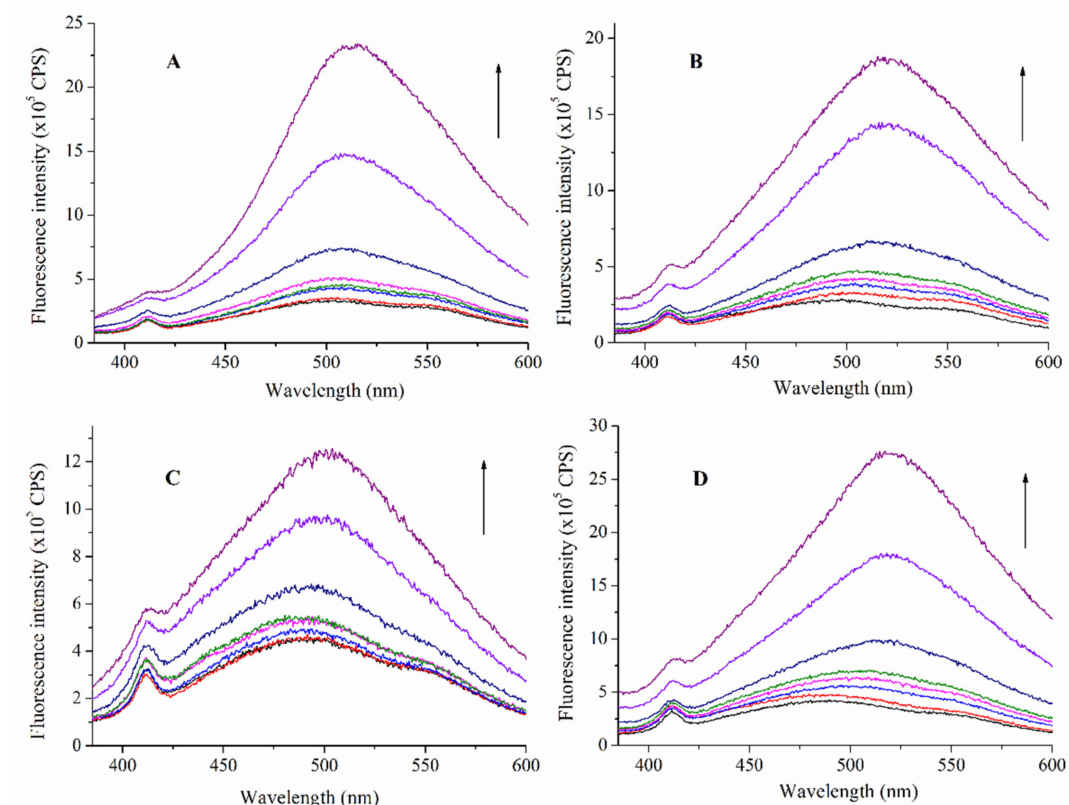
Figure 4. Fluorescence emission spectra of trans -PHX ( A , B ) and cis -PHX ( C , D ) (50 µ M) in the absence and presence of TAC ( A , C ) and TDC ( B , D ) (0–450 µ M) ( λ exc = 366 nm). The figure depicts the measurements that were carried out at 293 K. Arrows indicate increasing cavitand concentrations. Colors only support the